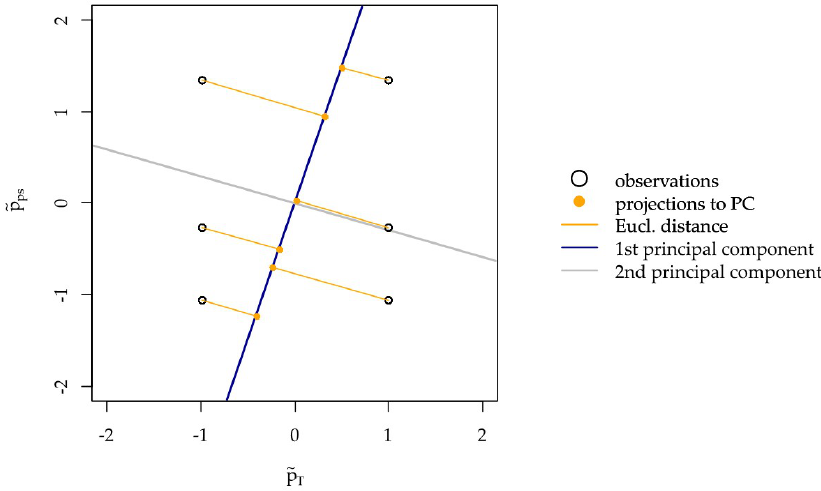
Figure 6. Normalized predictors and their distance to their 1-dimensional projections.